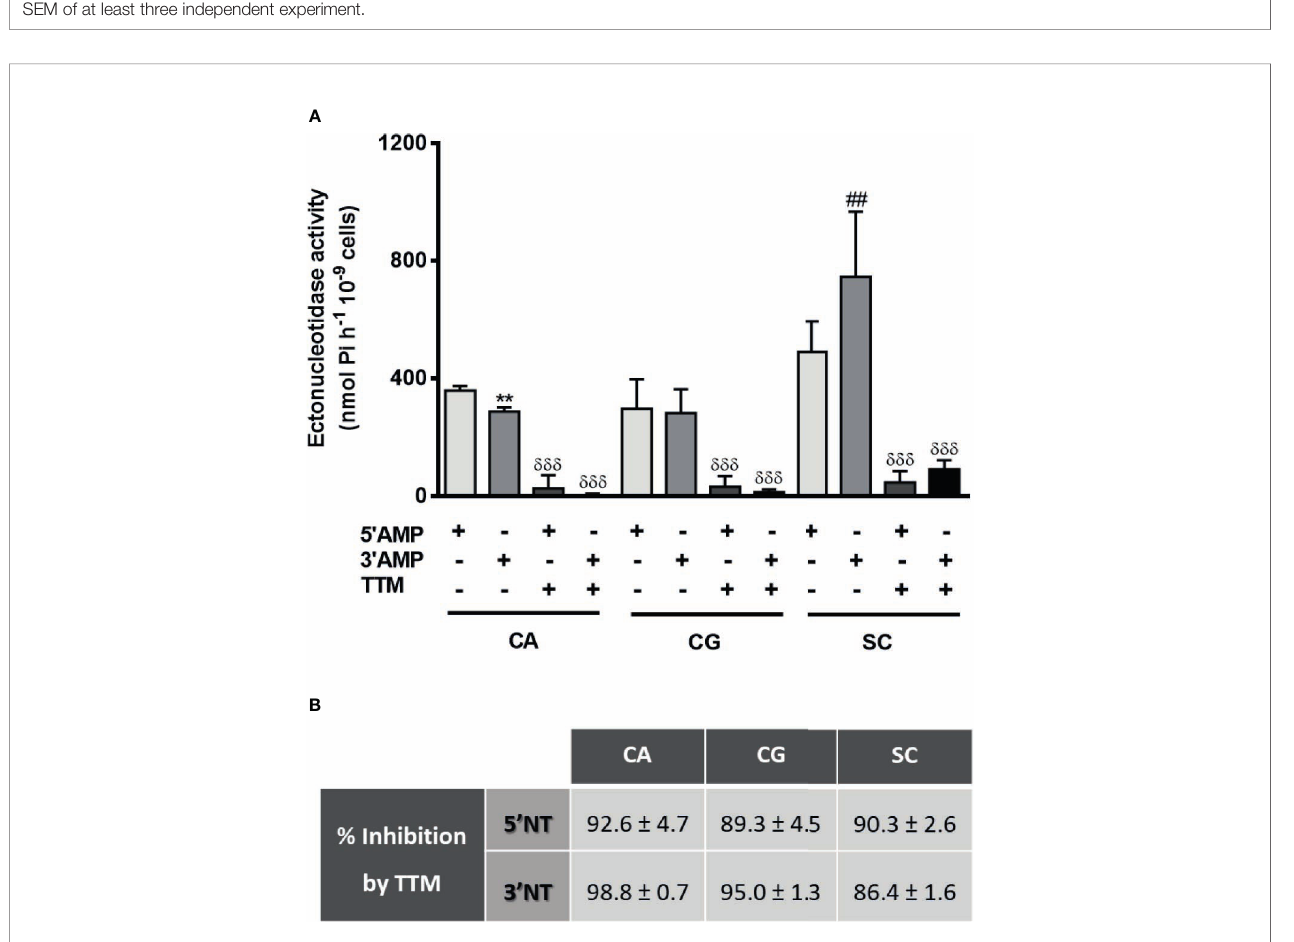
FIGURE 2 | Yeasts ectonucleotidases activity with TTM treatment. Intact cells of C. albicans (CA), C. glabrata (CG) and S . cerevisiae (SC) were incubated for 1 h at room temperature with 5 ′ AMP, 3 ′ AMP or TTM inhibitor together with each substrate (A) . Percentage of TTM inhibition for each condition is presented in (B) . Data are shown as means ± SEM of at least three independent experiments. **p<0.01, CA 3 ′ AMP vs. CA 5 ′ AMP; ## p<0.01, SC 3 ′ AMP vs. SC 5 ′ AMP; ddd p<0.001, TTM- treated yeasts vs. untreated.